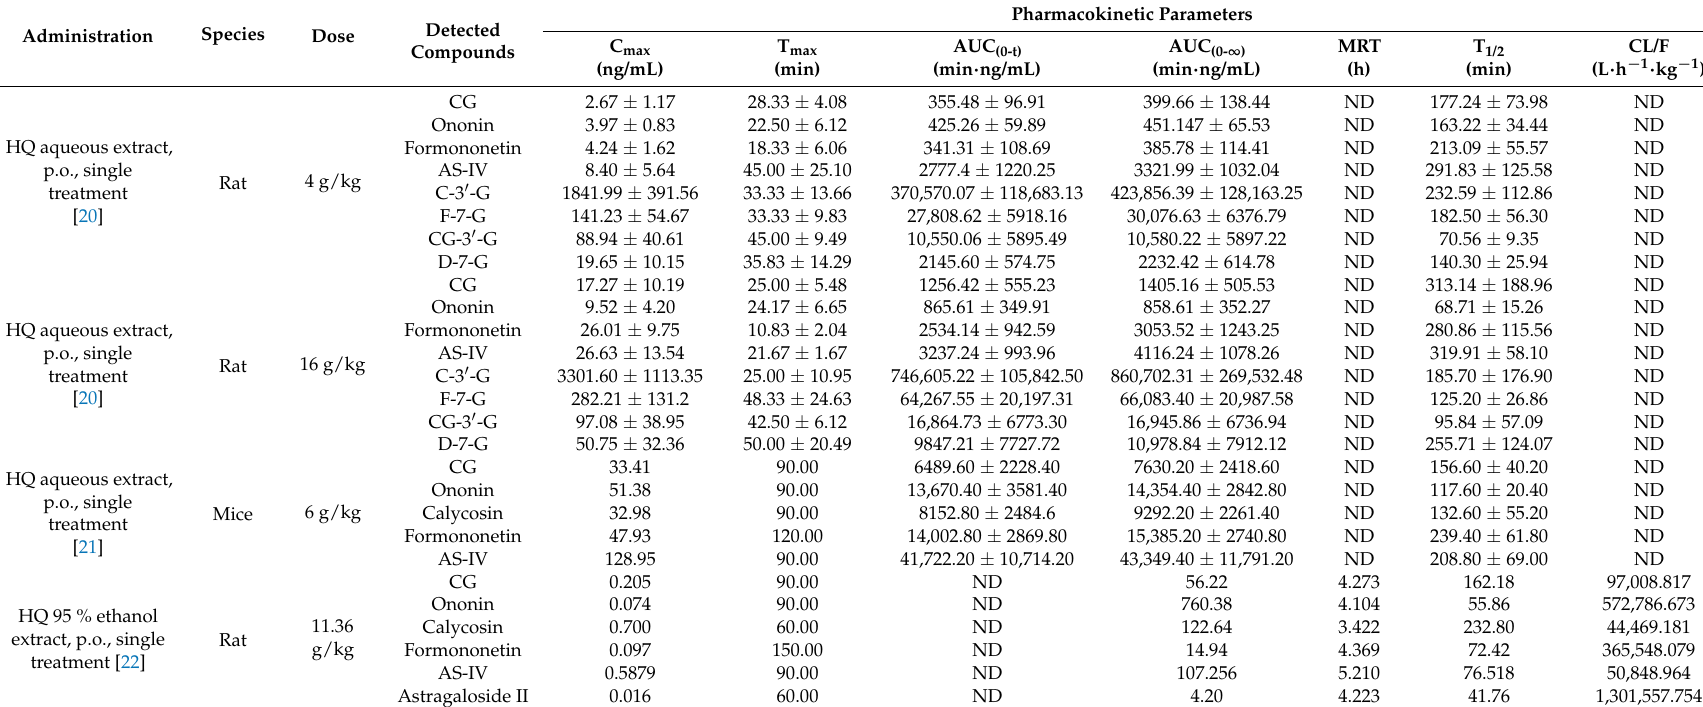
Table 2. Pharmacokinetic parameters of detected compounds following oral administration of AR